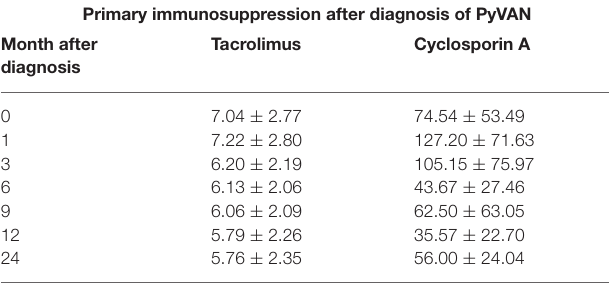
TABLE 3 | Level of calcineurin–inhibitors after the diagnosis of BK (PyVAN). Primary immunosuppression after diagnosis of